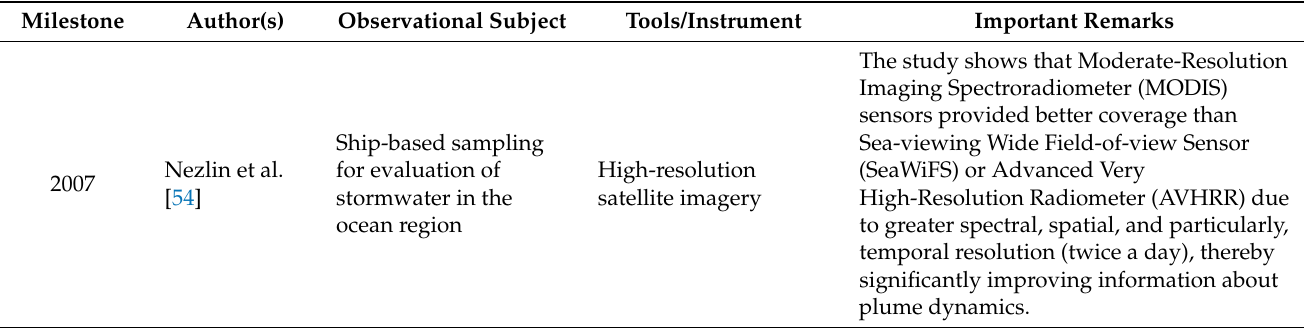
Figure 6. Comparison of the evaluated detection performance among ( a ) CFAR, F-RCNN, and Coupled-CNN E A; ( b ) SSD, MFLHD, and the method proposed by Dai et al. (redrawn based on data in Dai et al. [64] and Gui et al. [65]). Table 2. Landmark research on sensor engineering applied in logistic and shipping